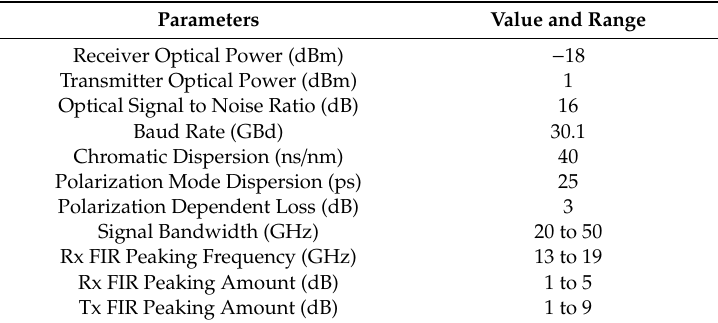
Table 2. Experimental parameters for the Rx FIR filter and the Tx FIR filter.